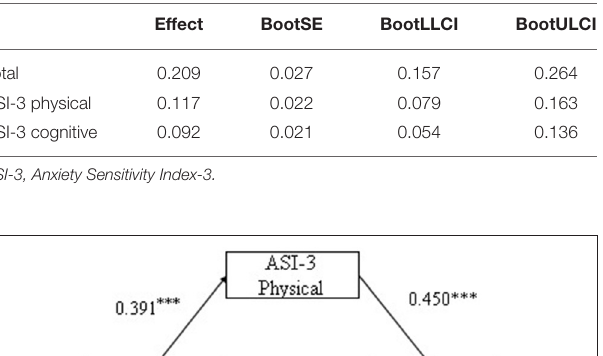
TABLE 5 | Regression analysis of variable relationships in models (physical, cognitive, and social concerns as mediating variables).